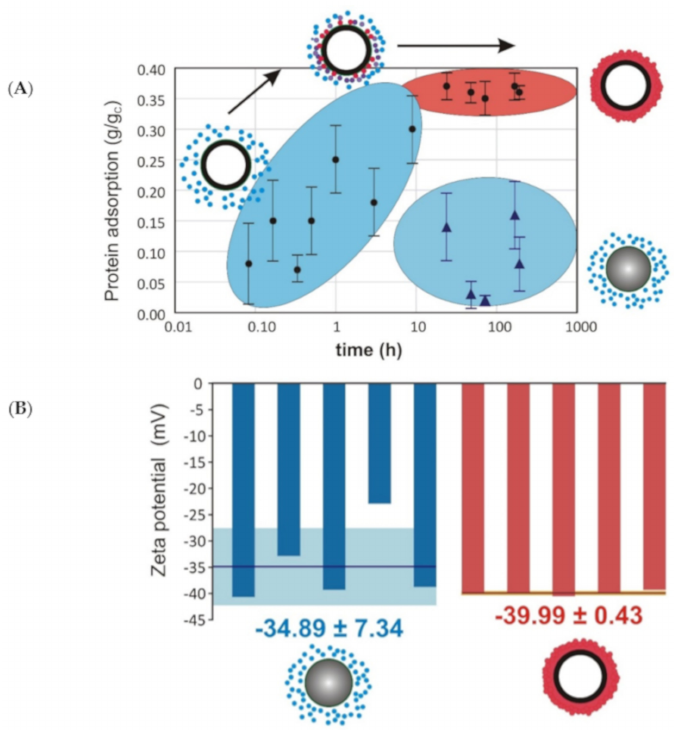
Figure 6. Protein-adsorption ( A ) and zeta-potential measurements ( B ) of carbonaceous nanomaterials: single-walled carbon nanotubes (empty circles) and amorphous carbon (filled